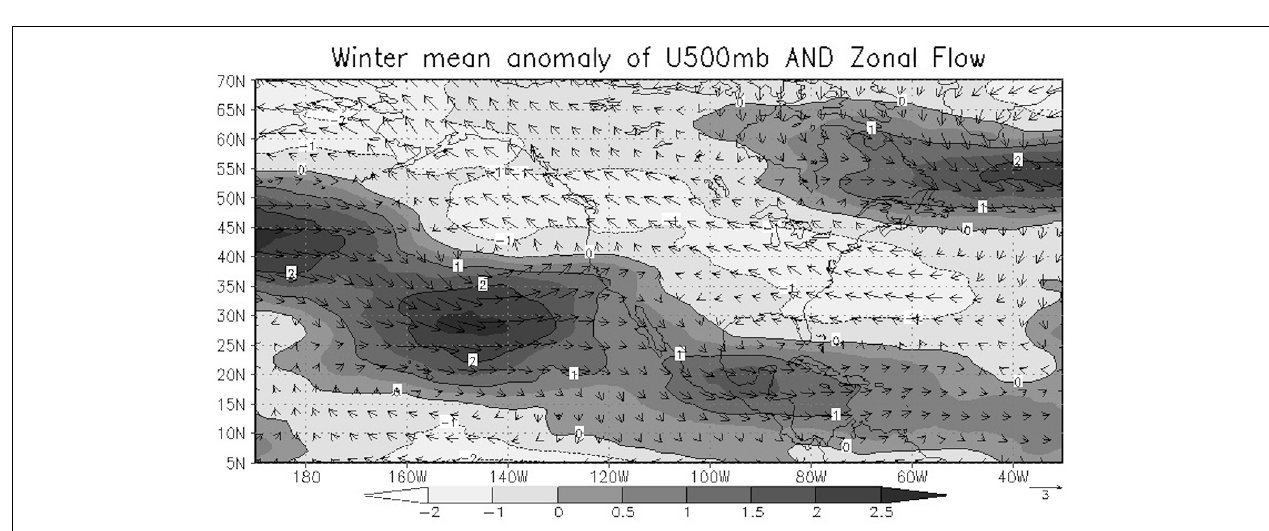
FIGURE 9 | Change of maximum Eady growth rate (day − 1 ) at 500hPa for the NH winter (2080–2089) minus (1980–1989).